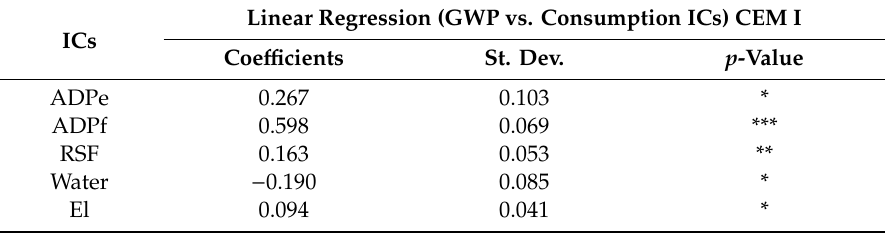
Table 12. AIC selection model (GWP vs. Consumption ICs)—CEM I.